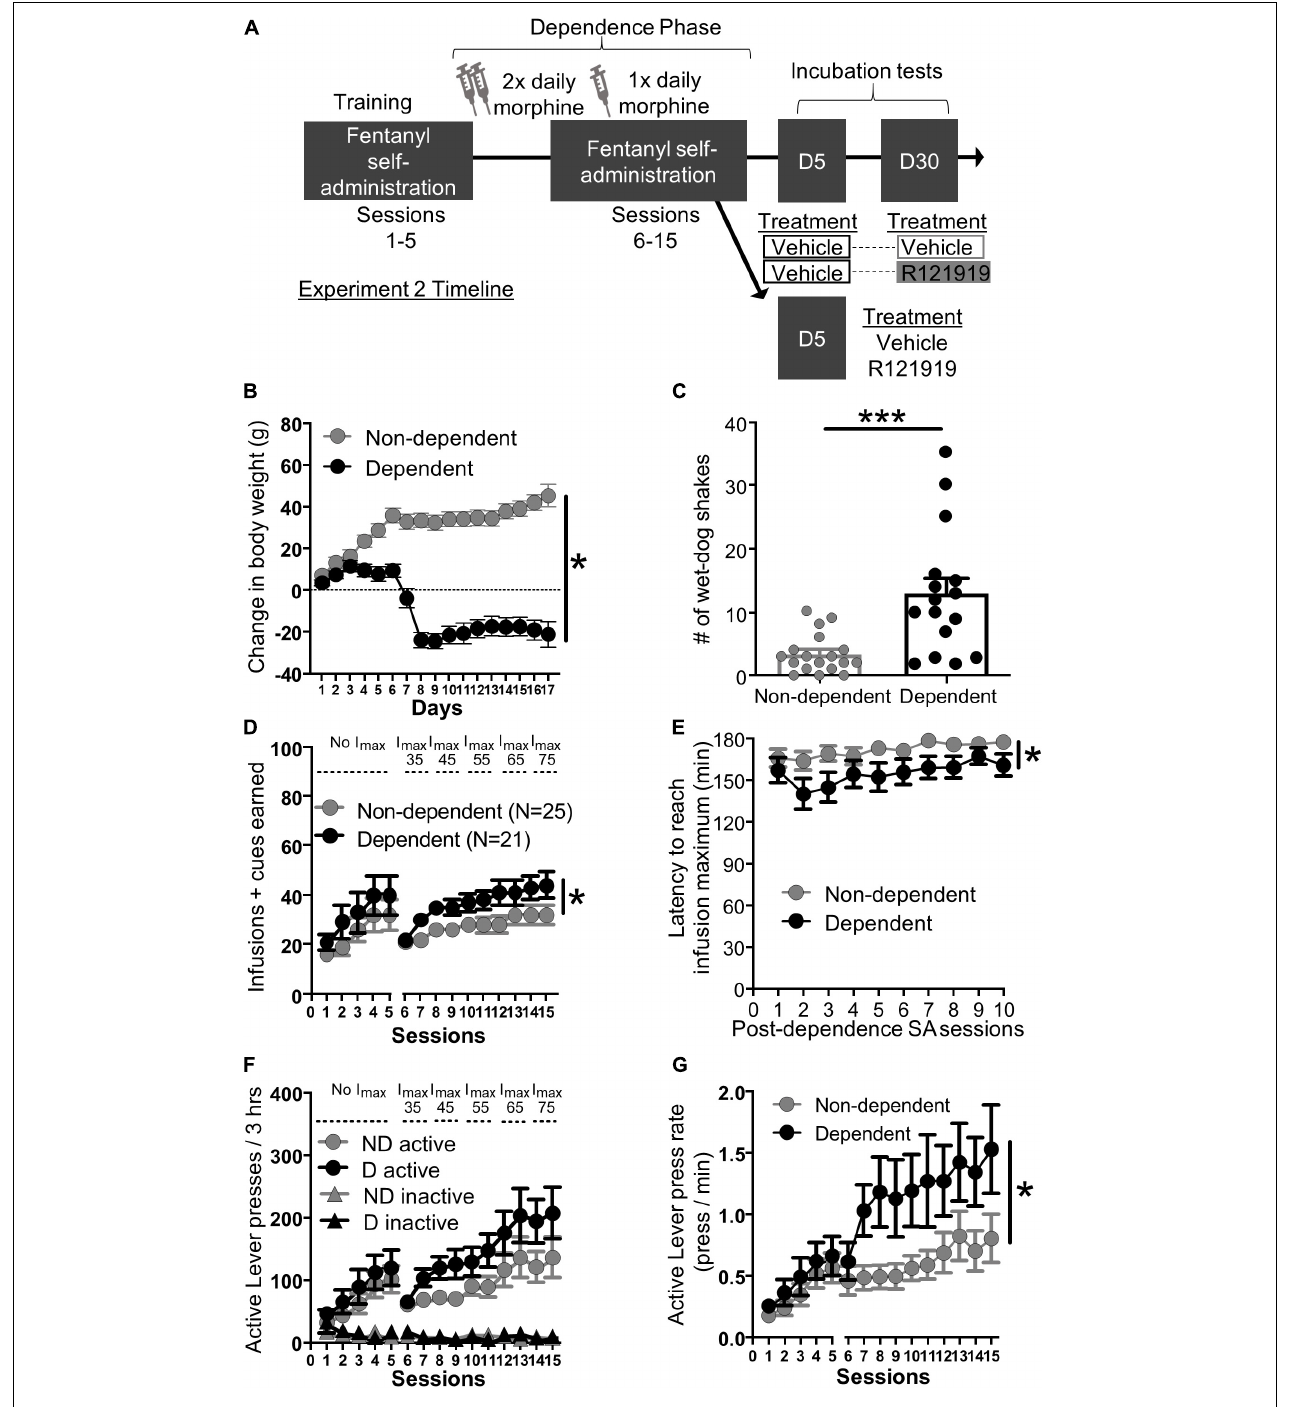
FIGURE 2 | Experiment 2: Fentanyl self-administration training in opioid dependent versus non-dependent rats. (A) Experimental timeline: We trained rats to self-administer fentanyl for 5 days before inducing opioid dependence. Rats resumed self-administration for 10 more days while dependence was maintained. On forced abstinence Day 5 and Day 30, we measured lever responding under extinction conditions. (B) Change in body weight across days for opioid-dependent and non-dependent rats after start of dependence phase. (C) Number of wet-dog shakes for opioid-dependent and non-dependent rats. (D) Fentanyl infusions + cues earned across the 15 3 h self-administration sessions, sessions 1–5: before dependence and no infusion maximum criteria, 6–15: during dependence with infusion maximum criteria. (E) Latency to reach infusion maximum criteria in minutes. (F) Active/Inactive Lever pressing for dependent and non-dependent rats during training. (G) Active Lever press rate. * p < 0.05, main effect of dependence, *** p < 0.001, different from non-dependent. SA, Self-administration; ND, non-dependent; D, dependent. Data are mean ± SEM.